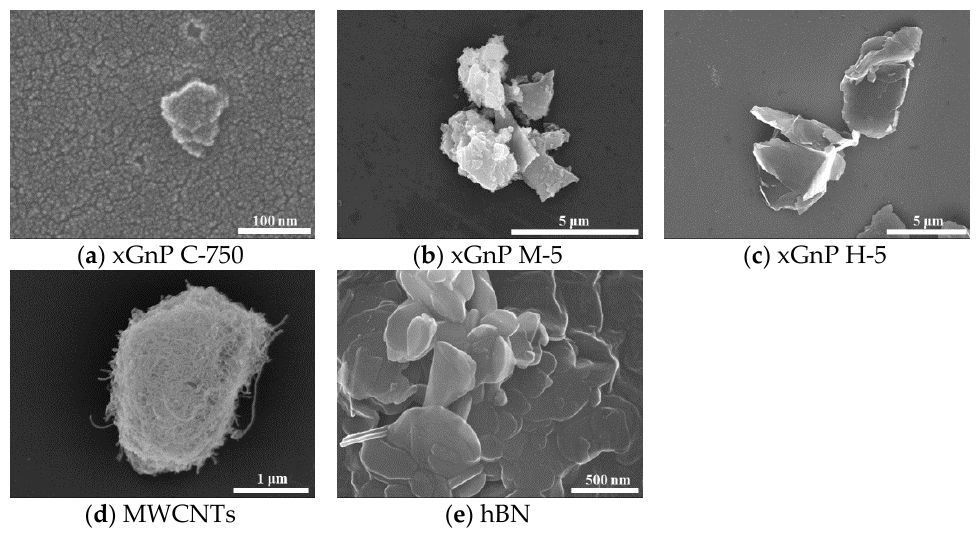
Figure 1. FE-SEM images of xGnPs, MWCNTs, and hBN.